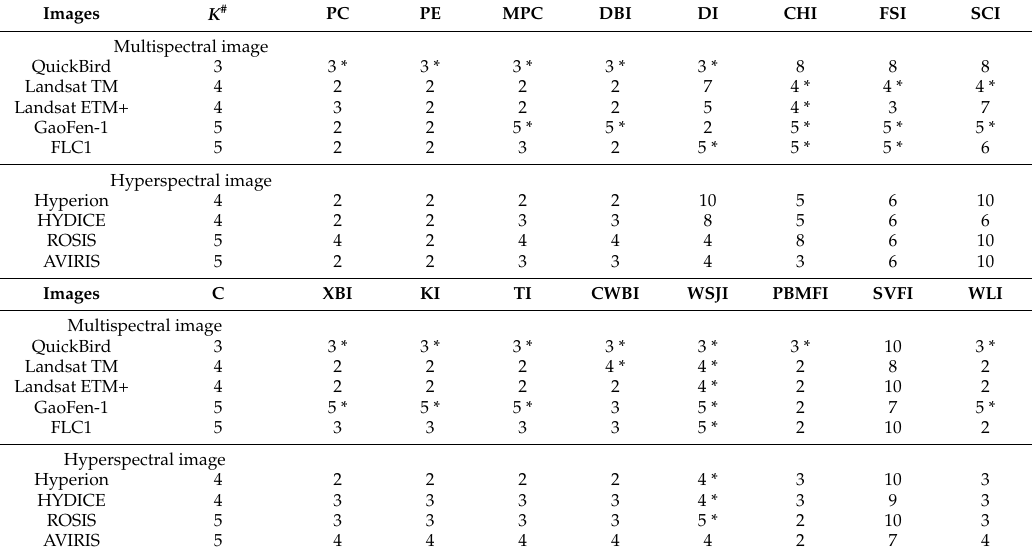
Table 12. The optimal cluster numbers indicated by the CVIs by FCM for each remote sensing image. Images K # PC PE Multispectral image QuickBird